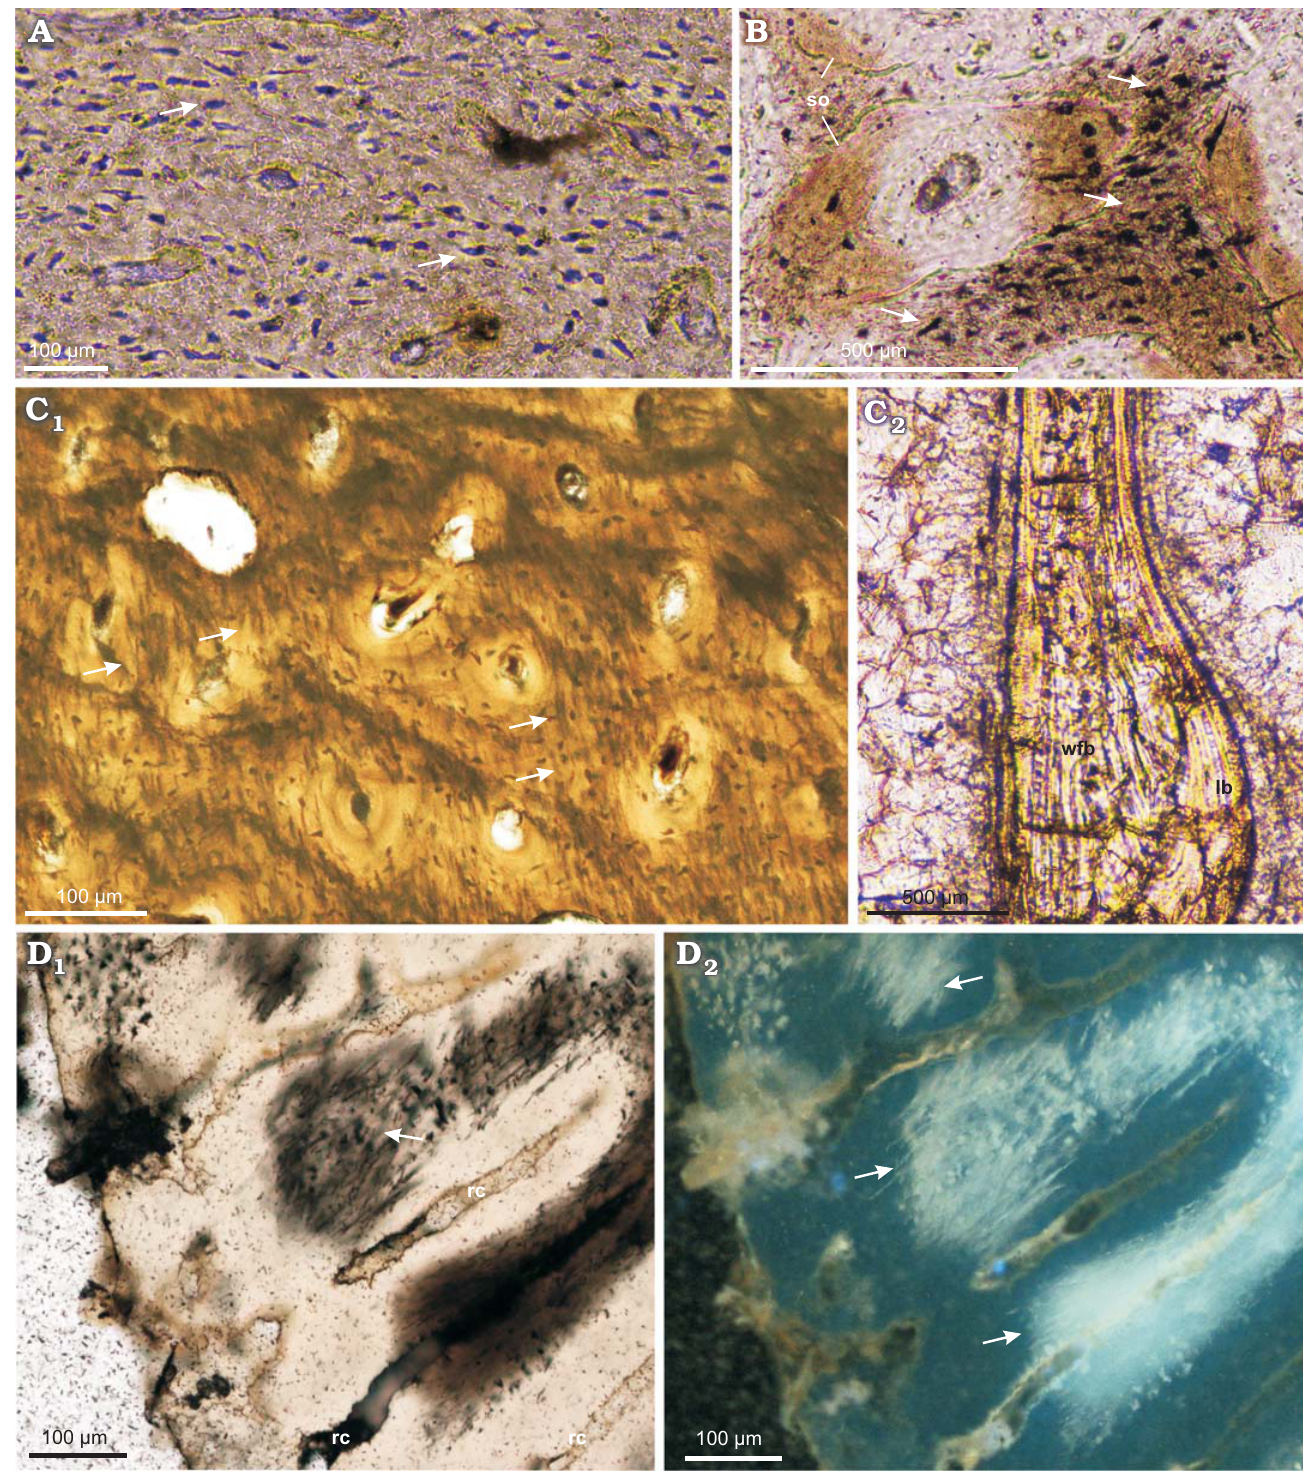
Fig. 3. Long bones microstructure of Protoceratops andrewsi Granger and Gregory, 1923, Toogreek (A) and Bayn Dzak (B–D), Mongolia, Late Creta- ceous. A , B . Osteocyte lacunae (arrows) in cortex of subadult tibia ZPAL MgD-II/35c ( A ) and juvenile femur ZPAL MgD-II/407 ( B ). C . ZPAL MgD- II/11b, adult fibula showing in situ arrangement and abundance of fossilized fibers (arrows) in the cortex (C 1 ) and a structure of the trabeculae with woven- fibered bone in the core lined with lamellar bone (C 2 ). D . ZPAL MgD-II/3d, subadult femur with flocculated collagenous fibers (arrows) at the polished cross section. A–C, D 1 , normal light; D 2 , UV light. Abbreviations: lb, lamellar bone; rad, radial canals; so, secondary osteons; wfb, woven-fibered Rib .—The rib tissue has been studied only in ZPAL bone element should be treated as preliminary. The rib of MgD-II/3b; thus, the data on the microstructure of this Protoceratops is a strongly flattened and gently arched bone